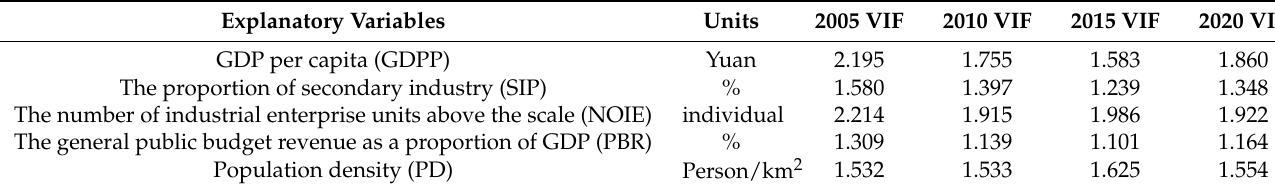
Table 1. Diagnostic results of multicollinearity in explanatory